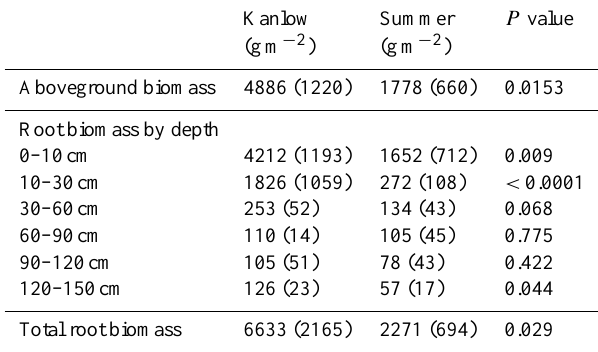
Table 2. Aboveground plant biomass (including crowns) and be- lowground root biomass per ground area (gm − 2 ) and standard de- viation (in parentheses) for switchgrass lowland (Kanlow) ecotype and upland ecotype (Summer). P values equal to or below 0.05 in- dicate whether the difference in biomass is significantly different between Kanlow and Summer in the aboveground plant sampling, the total root biomass, and at every individual sampling depth.